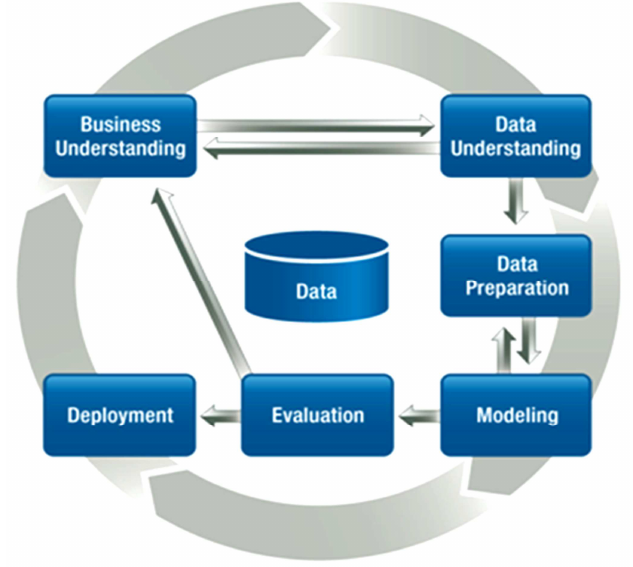
Figure 2. Phases of the CRISP-DM reference